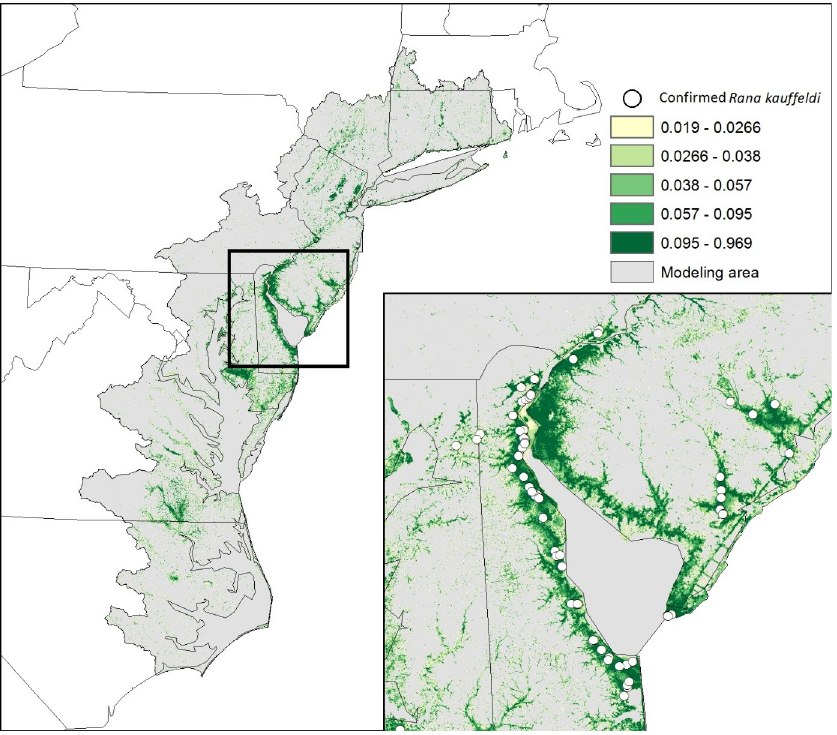
Fig 6. Distribution model for the full range of R . kauffeldi along the coastal northeastern U.S. Inset: Delaware Bay and surrounding states. Values reflecting habitat suitability were broken into 10 quantiles, with the top five displayed.